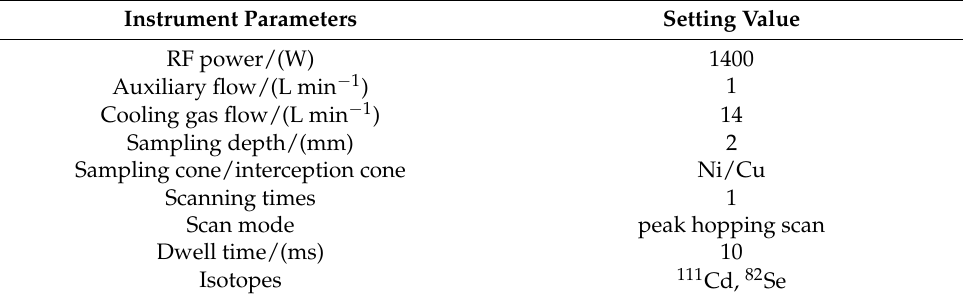
Table 4. Instrumental program of ICP-MS for direct sampling